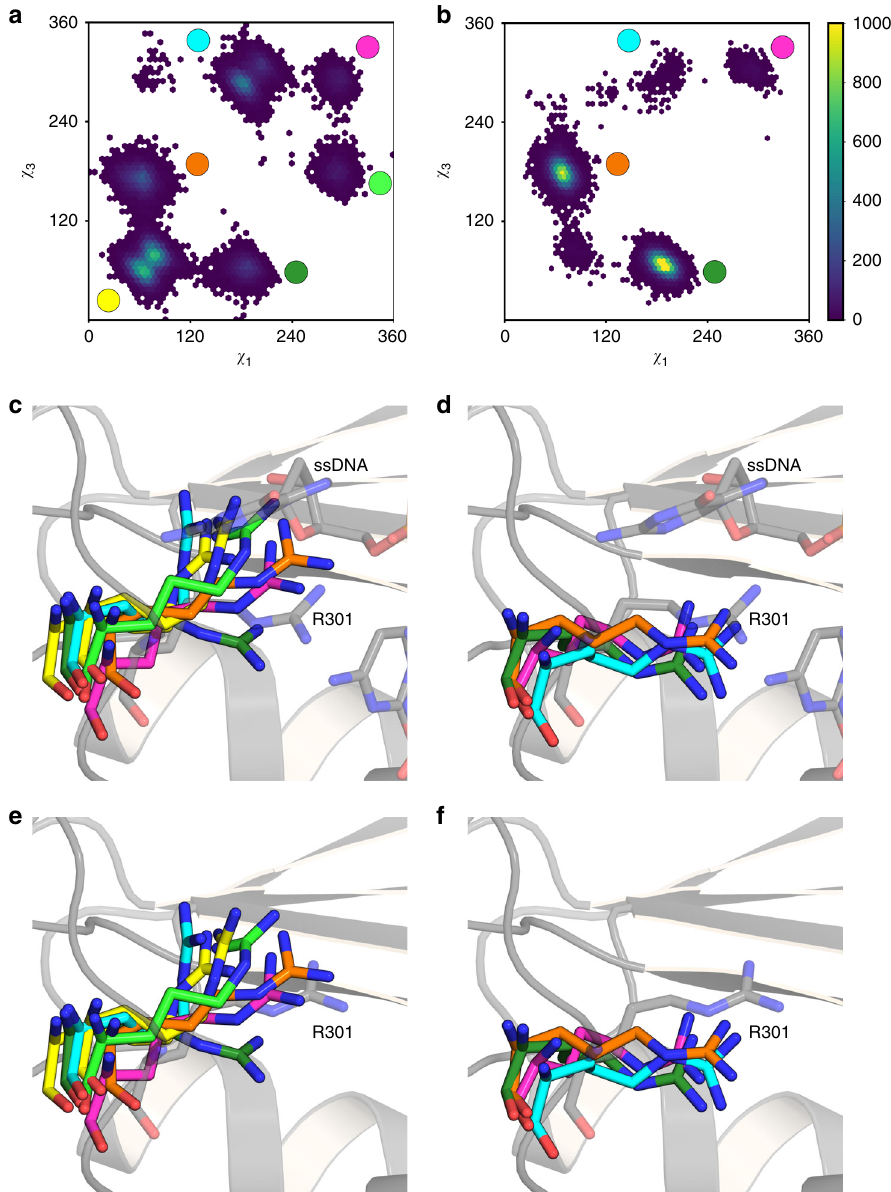
Fig. 6 Population distributions of the χ 1 and χ 3 dihedral angles (°) of the R301 side chain of the P301R mutant forms of the exonuclease domain of Pol ε . Τ he dihedral angles formed by N – C α – C β – C γ and C β – C γ – C δ – N ε , respectively. The colors shown in the heat maps correspond to frequencies each value is sampled during the simulation. Shown here are the population distributions from ( a ) the apo-enzyme and ( b ) the enzyme in complex with ssDNA. As can be seen, the R301 side chain takes multiple conformations during each simulation. Selected conformations of this sidechain, corresponding to structures from highly populated clusters in ( a , b ) are shown in ( c , d ) for the apo-enzyme and the enzyme in complex with ssDNA, respectively, with the corresponding regions in ( a , b ) marked by circles in the same color as the side-chains. The starting structure used for simulations is depicted in gray color. Note that in the case of the structures from the simulations of the apo-enzyme ( c ), we have placed the ssDNA in the background fi gure in gray as a point of reference only. The selected conformations of the R301 side chain in ( e , f ) are identical to ( c , d ) but with the background fi gure replaced by the crystal structure of P301R in gray as a point of